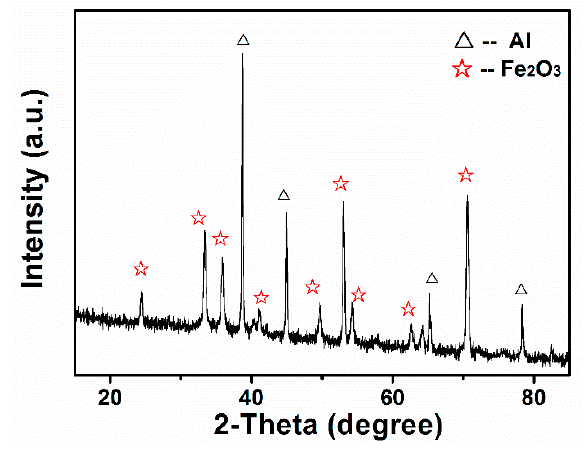
Figure 2. The typical XRD spectra of the SAFFs.